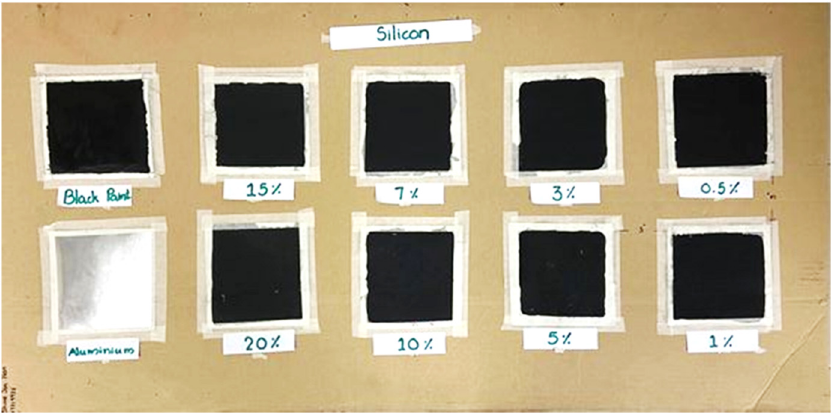
Figure 2. Samples under investigation.